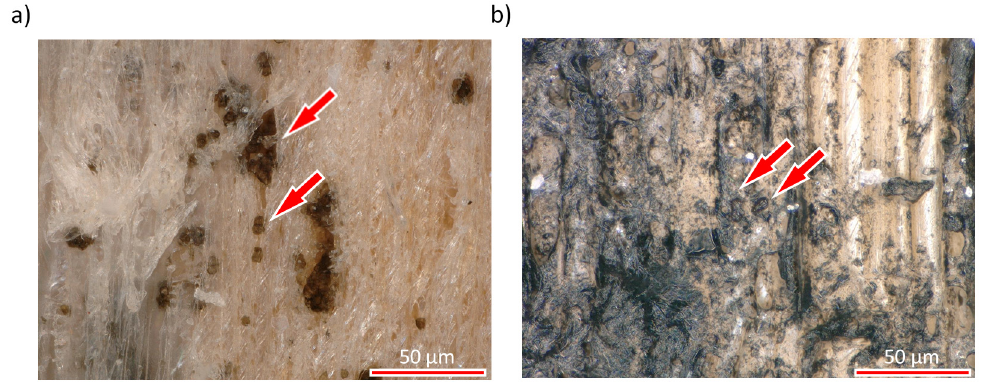
Figure 8. Chlamydospores of A. pullulans on the surface of uncoated Scots pine after 9 months of exposure ( a ) and a biofinish-coated reference sample not exposed to natural weathering ( b ), observed under microscope with ×1000 magnification.